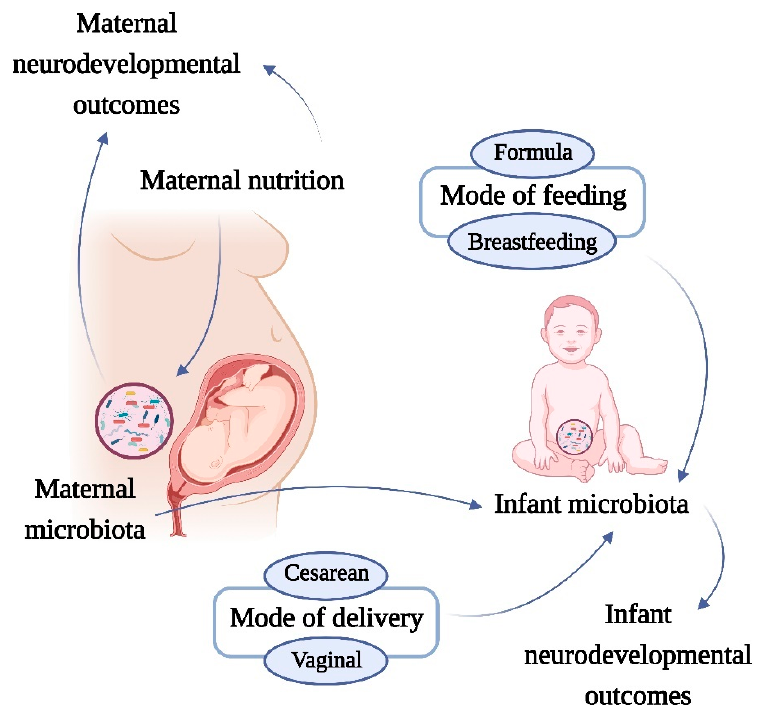
Figure 1. Effects of maternal microbiota and nutrition on neurodevelopmental disorders. The increase in prevalence of nutrition-related metabolic diseases has been paralleled by an increase in neurological problems, both in adults and in children. A possible mechanistic pathway linking nutrition and neurodevelopmental outcomes is the microbiota. Several factors can affect the neonatal microbiome. The microbiota is shared between mother and child, therefore the maternal diet, mode of feeding and mode of delivery can influence the microbiota of the offspring. This complex network involving early-life microbiota development can induce changes that link with the neurodevelopmental disorders of the infant.